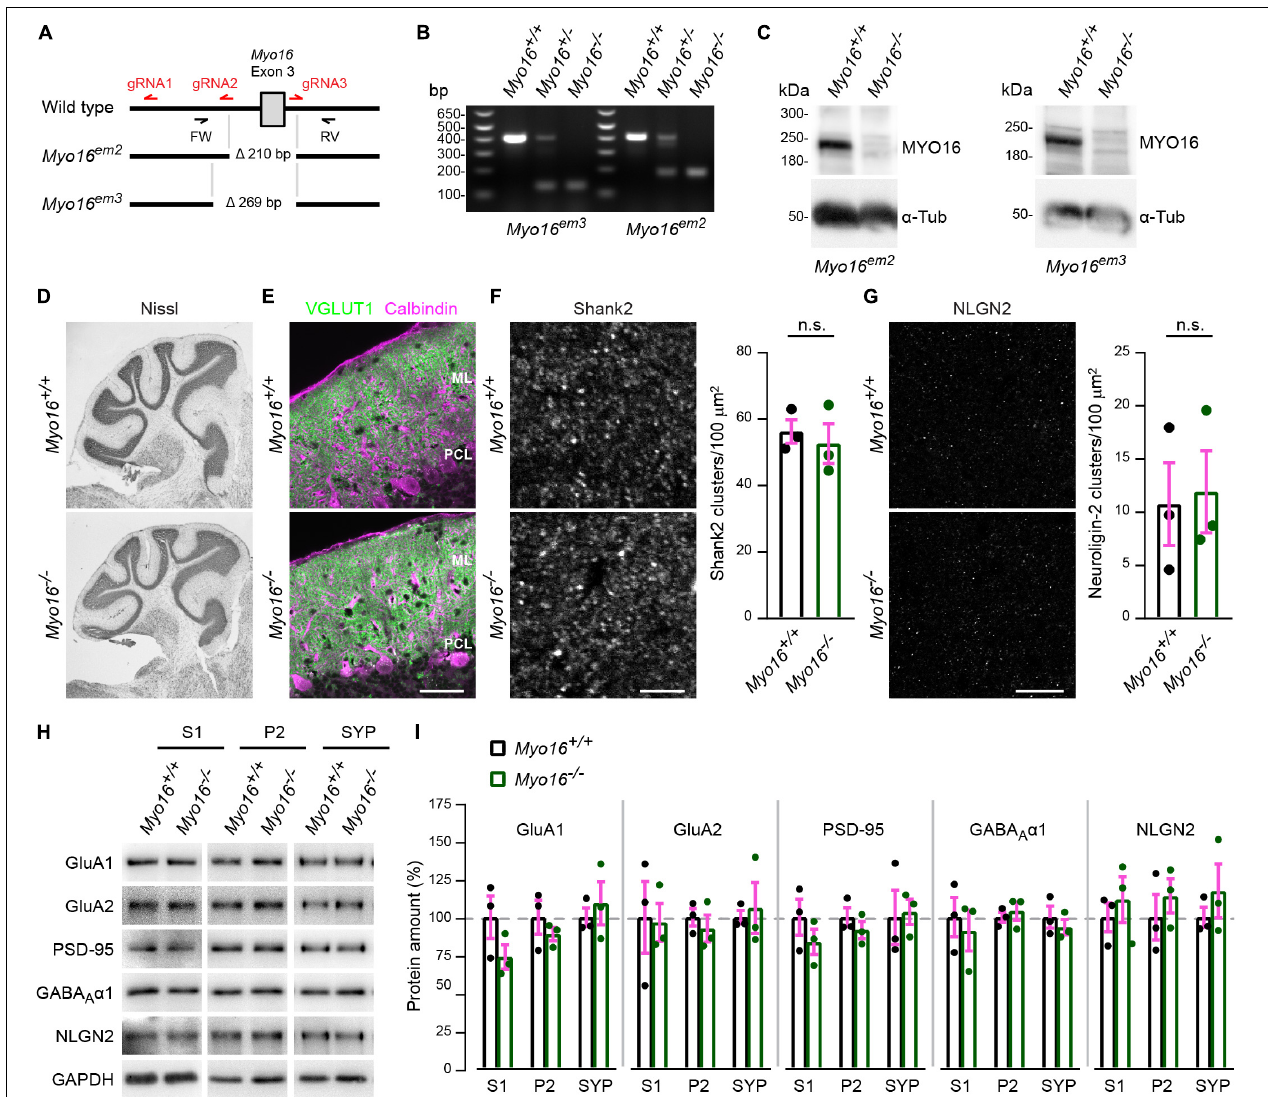
FIGURE 1 | Generation and initial characterization of Myo16 knockout mice. (A) Overview of CRISPR/Cas9-mediated creation of Myo16 knockout mice (see section “Materials and Methods” for details). Guide RNA sequences are indicated in red (gRNA1-3). Mouse lines carrying deletions of 210 bp ( Myo16 em 2 ) and 269 bp ( Myo16 em 3 ) were obtained, with both deletions comprising exon 3 of Myo16 . Genotyping primers indicated (FW, RV). (B) Identification of mice that are hetero- or homozygous carriers of the Myo16 em 3 and Myo16 em 2 alleles via PCR genotyping using FW and RV primers. Shown is an agarose gel on which the obtained DNA fragments were separated. (C) Absence of MYO16 protein in cerebellum extracts of homozygous Myo16 em 2 and Myo16 em 3 mice. Western blot analysis was performed using cerebellar extracts from 11 day old wild-type ( Myo16 + / + ) and homozygous knockout ( Myo16 − / − ) mice. Antibodies against MYO16 (pre-adsorbed as described in section “Materials and Methods”) and α -Tubulin ( α -Tub; loading control) were used. (D) Nissl staining of sagittal cerebellar sections from adult wild-type ( Myo16 + / + ) and Myo16 em 3 knockout ( Myo16 − / − ) mice. (E) Sagittal cerebellar sections from adult wild-type ( Myo16 + / + ) and Myo16 em 3 knockout ( Myo16 − / − ) mice immuno-fluorescently labeled with antibodies against VGLUT1 (PF terminal marker) and Calbindin-D-28K (Purkinje cell marker). ML, molecular layer; PCL, Purkinje cell layer. Scale bar, 50 µ m. (F) Sagittal sections of the cerebellar molecular layer from adult Myo16 + / + and Myo16 em 3 knockout mice ( Myo16 − / − ) were immuno-fluorescently labeled with antibodies against Shank2. Graph depicts number of Shank2 clusters per 100 µ m 2 as mean ± SEM (magenta), n = 3 (single data points represent mice analyzed), no significant differences detected (n.s.; Student’s t -test; see section “Materials and Methods”). Scale bar, 5 µ m. (G) Sagittal sections of the cerebellar molecular layer from adult Myo16 + / + and Myo16 em 3 knockout mice ( Myo16 − / − ) were immuno-fluorescently labeled with antibodies against neuroligin-2 (NLGN2). Graph depicts number of NLGN2 clusters per 100 µ m 2 as mean ± SEM (magenta), n = 3 (single data points represent mice analyzed), no significant differences detected (n.s.; Student’s t -test). Scale bar, 20 µ m. (H,I) Cerebellar extracts of 25 week old Myo16 + / + and Myo16 em 3 knockout mice ( Myo16 − / − ) were subjected to subcellular fractionation. S1, P2, and SYP fractions were analyzed by Western blot using the indicated antibodies. In (I) , quantification of the indicated proteins from Western blots of S1, P2, and SYP fractions of Myo16 + / + and Myo16 − / − mice is shown. Graphs depict protein amount after normalization to GAPDH loading control, as percentage of the mean protein amount in the respective Myo16 + / + fraction. Bars represent mean values ( n = 3; data points represent mice analyzed) ± SEM (magenta), no significant differences were detected when comparing protein amounts between the same fraction (S1, P2, or SYP) of Myo16 + / + and Myo16 − / − mice (n.s.; Student’s t -test).